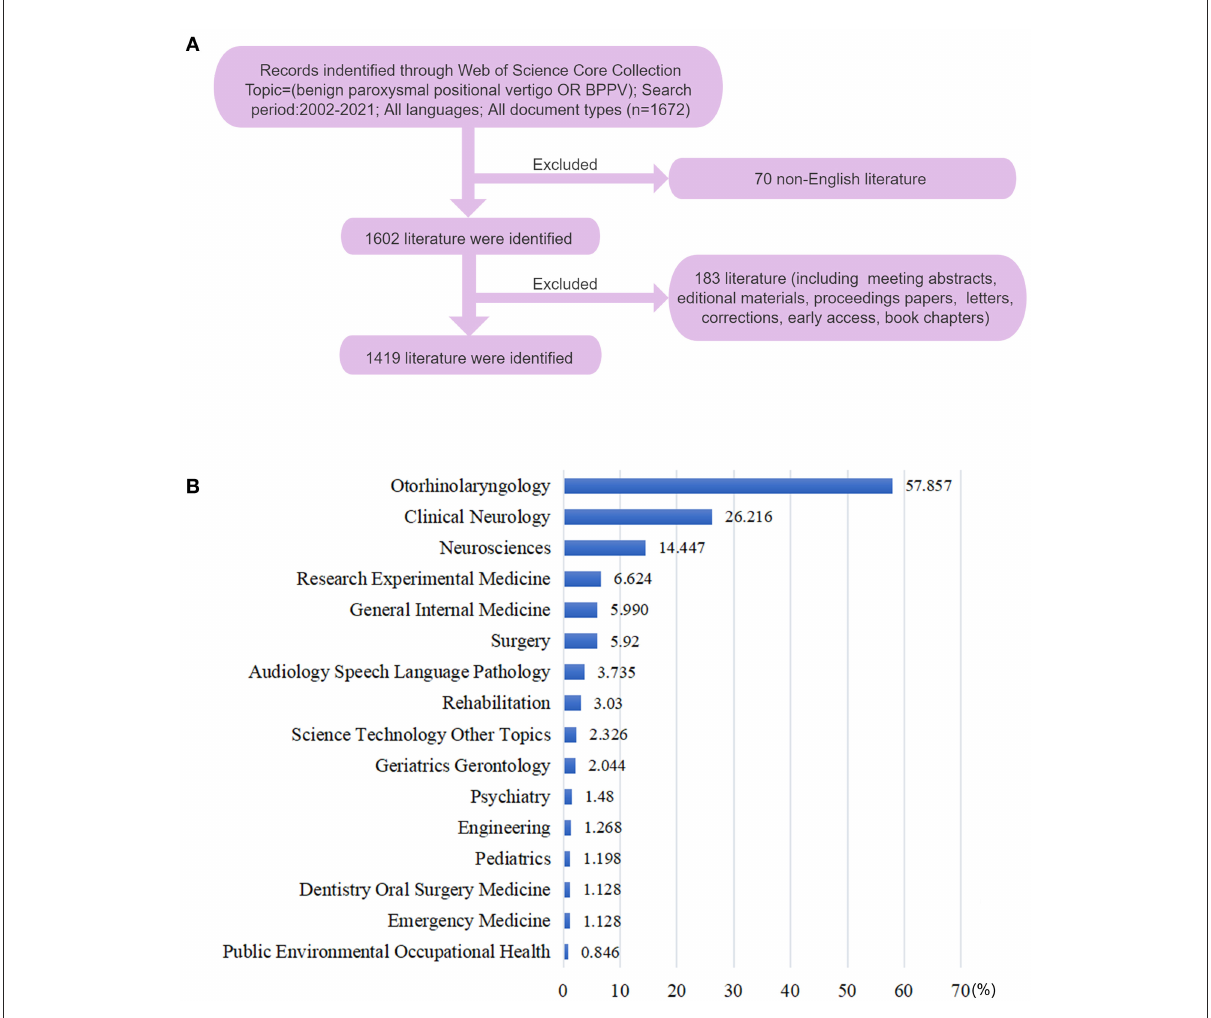
FIGURE1 (A) Flow diagram of the publication selection process for a bibliometric analysis. (B) Subject categories of the